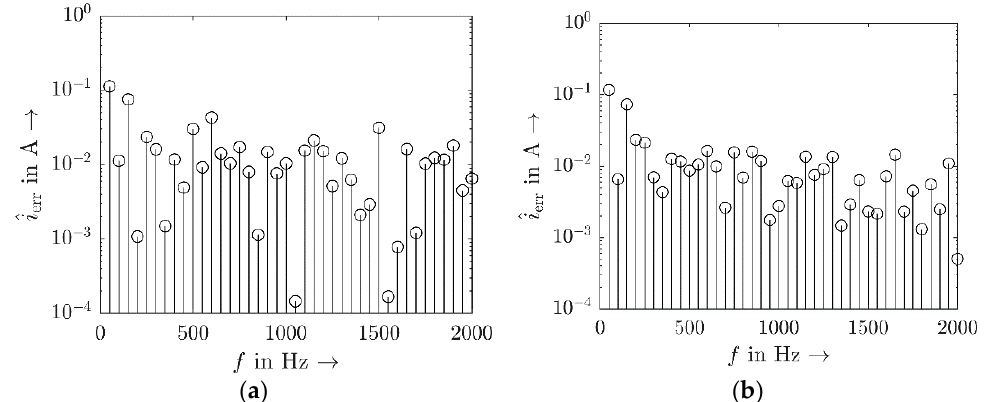
Figure 9. Absolute error of the amplitude spectrum î AC for ( a ) a single-frequent 500 Hz distortion of u AC and ( b ) a multi-